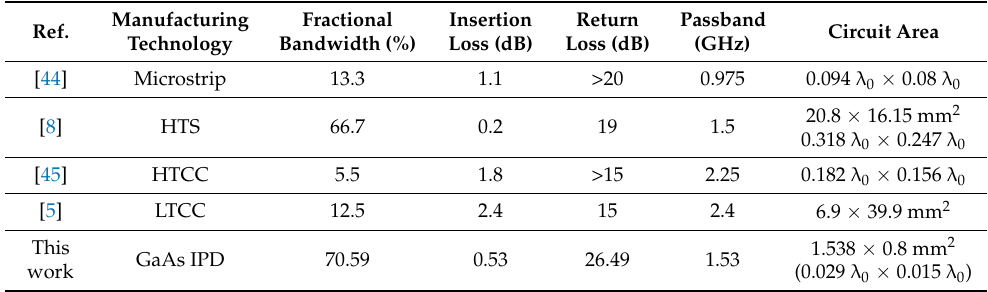
Table 5. Comparisons between this study and other works using various manufacturing technologies.